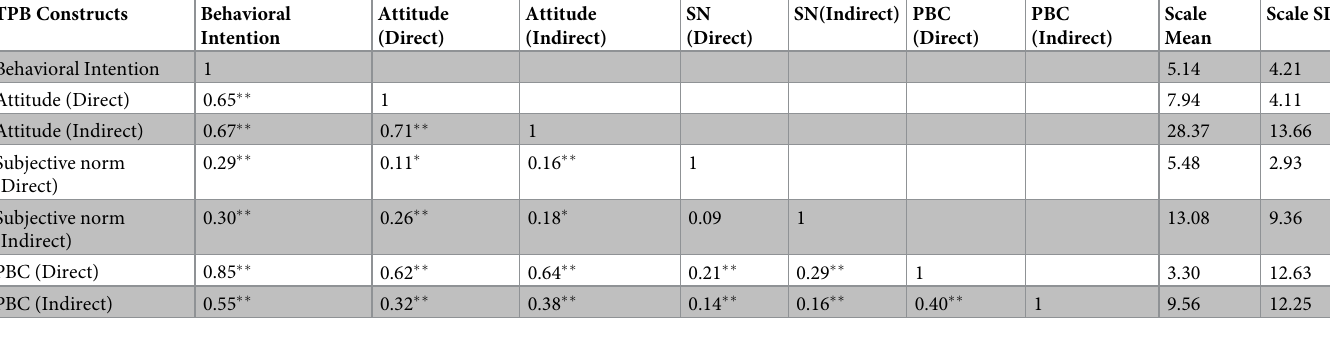
Table 2. Descriptive statistics and correlations of TPB constructs among households of Butajira town, Southern Ethiopia, 2020 (N = 422). TPB